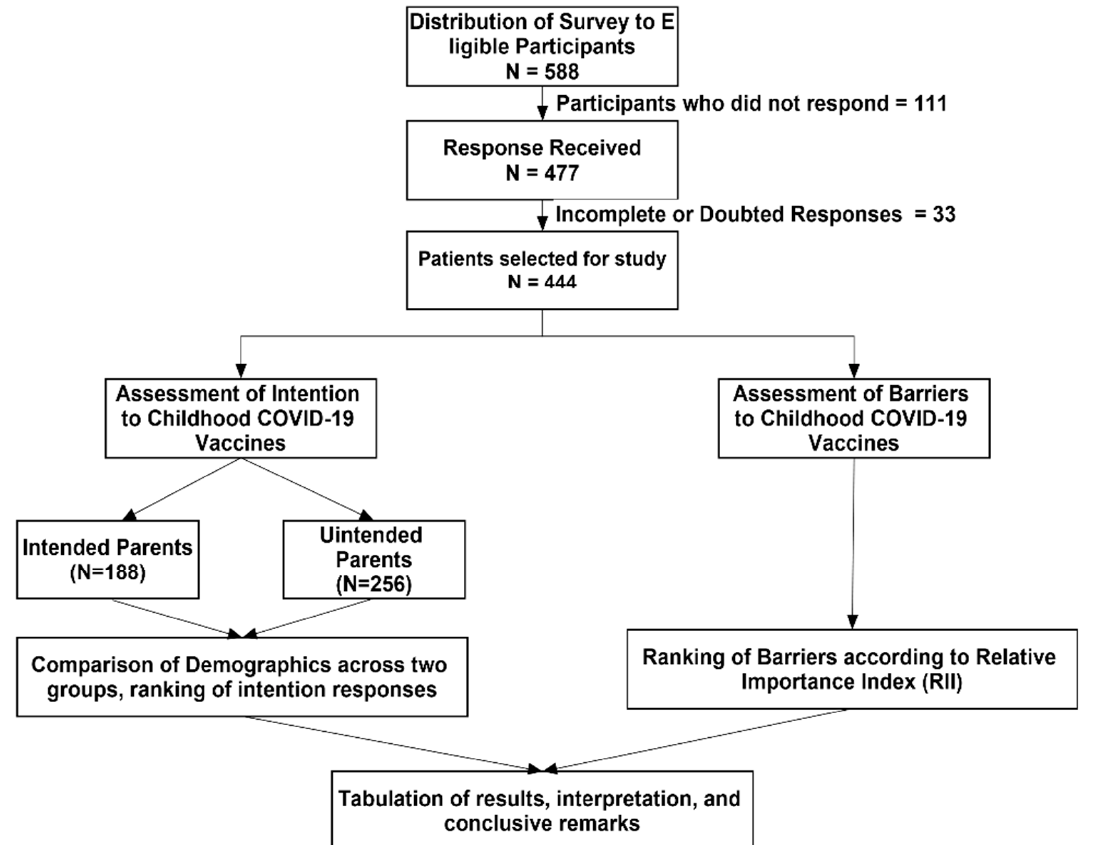
Figure 1. Methodological flowchart of the study.